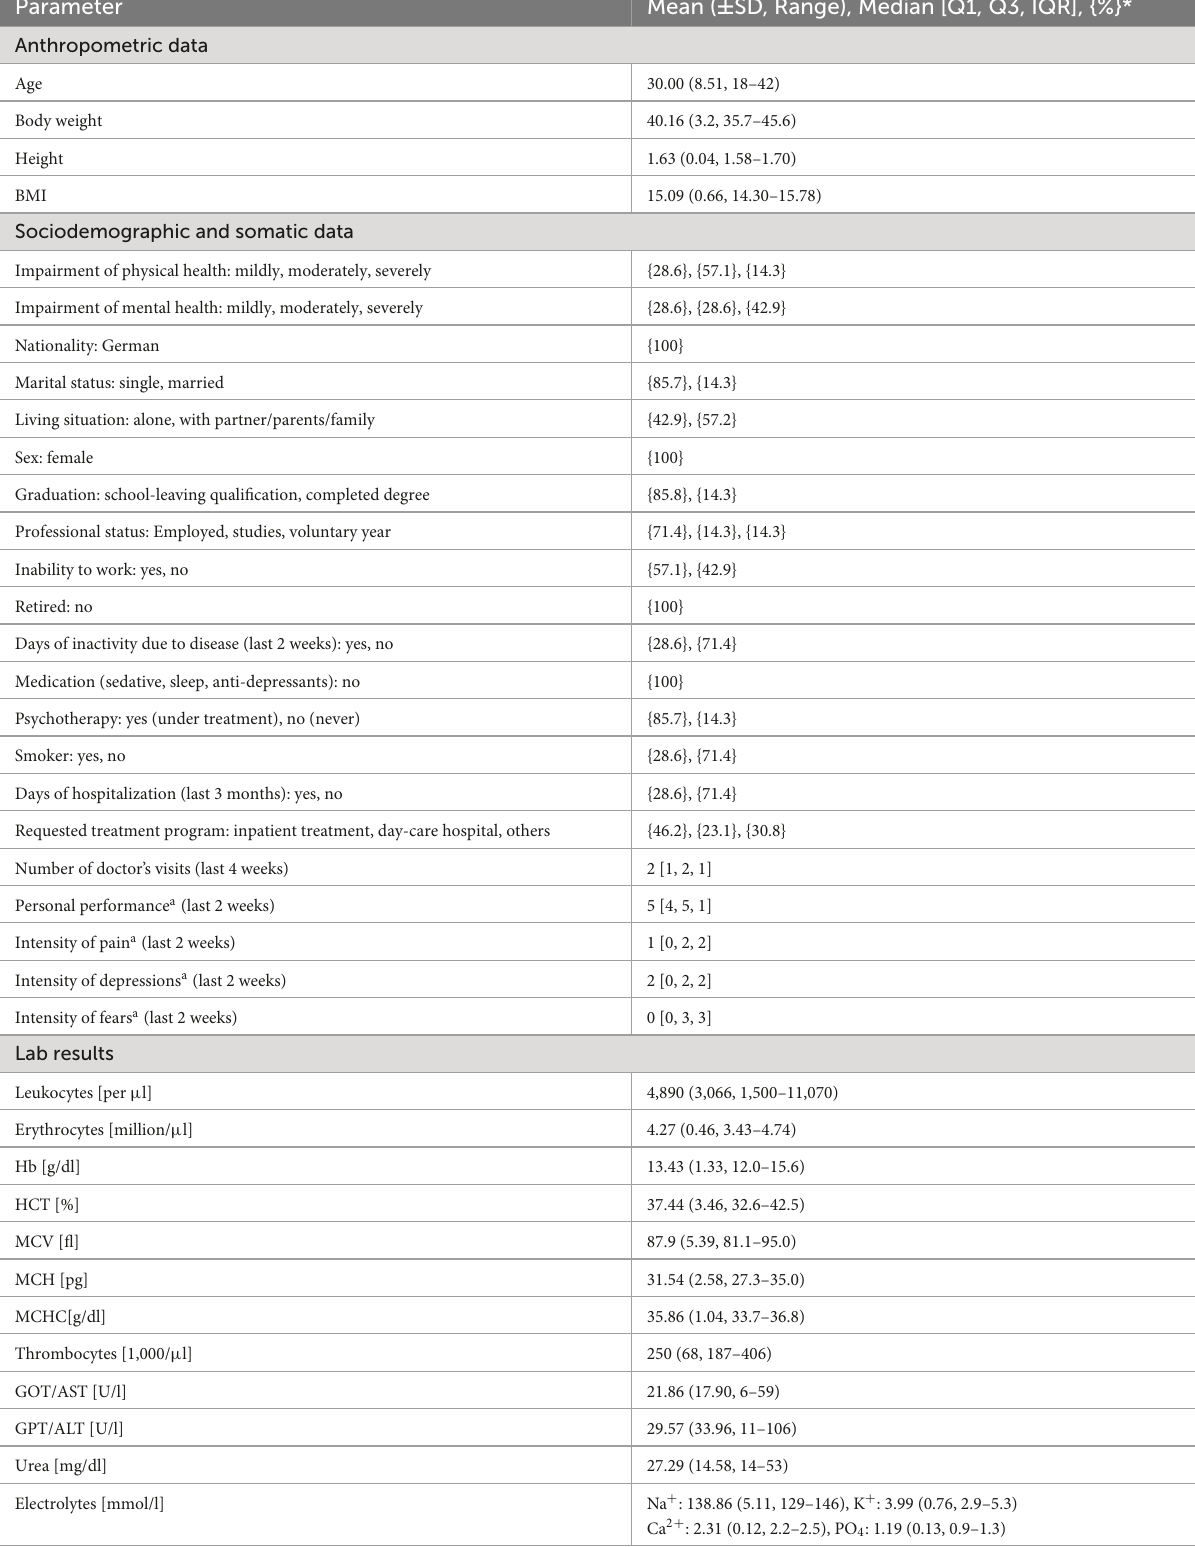
TABLE 2 Descriptive analysis of anthropometric, sociodemographic, laboratory, and psychometric data.